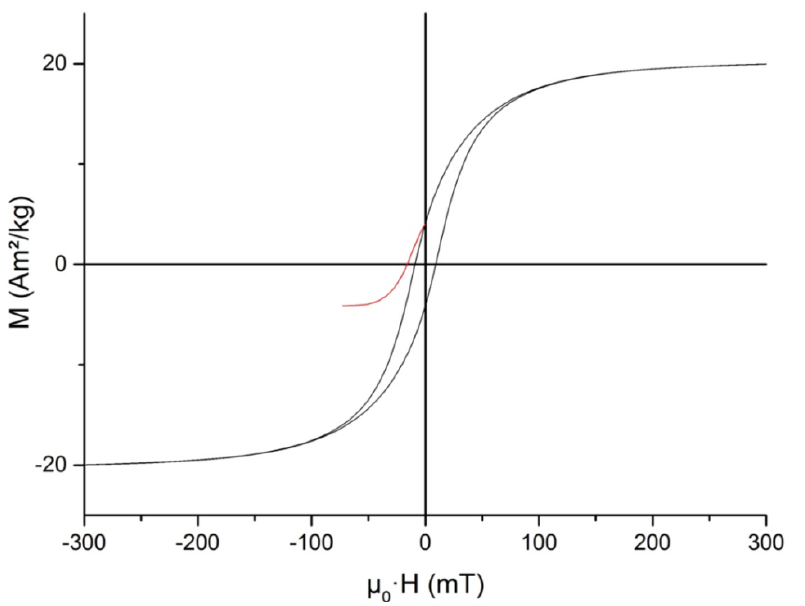
Figure 7. Central part of static hysteresis loop and saturation isothermal remanent magnetization backfield curve of the isolated magnetosomes measured at 295 K. Table 1. Comparison of the hysteresis characteristics of bacterial magnetosomes isolated from various species (strains) of MTB at room temperature.